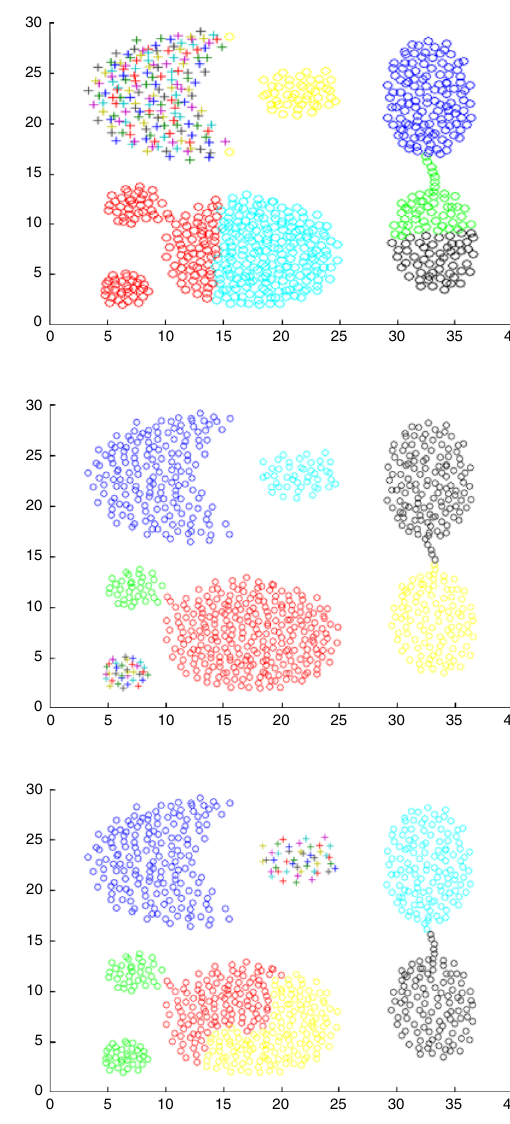
Figure 10. Result of complete-link on “ Aggregation ” data